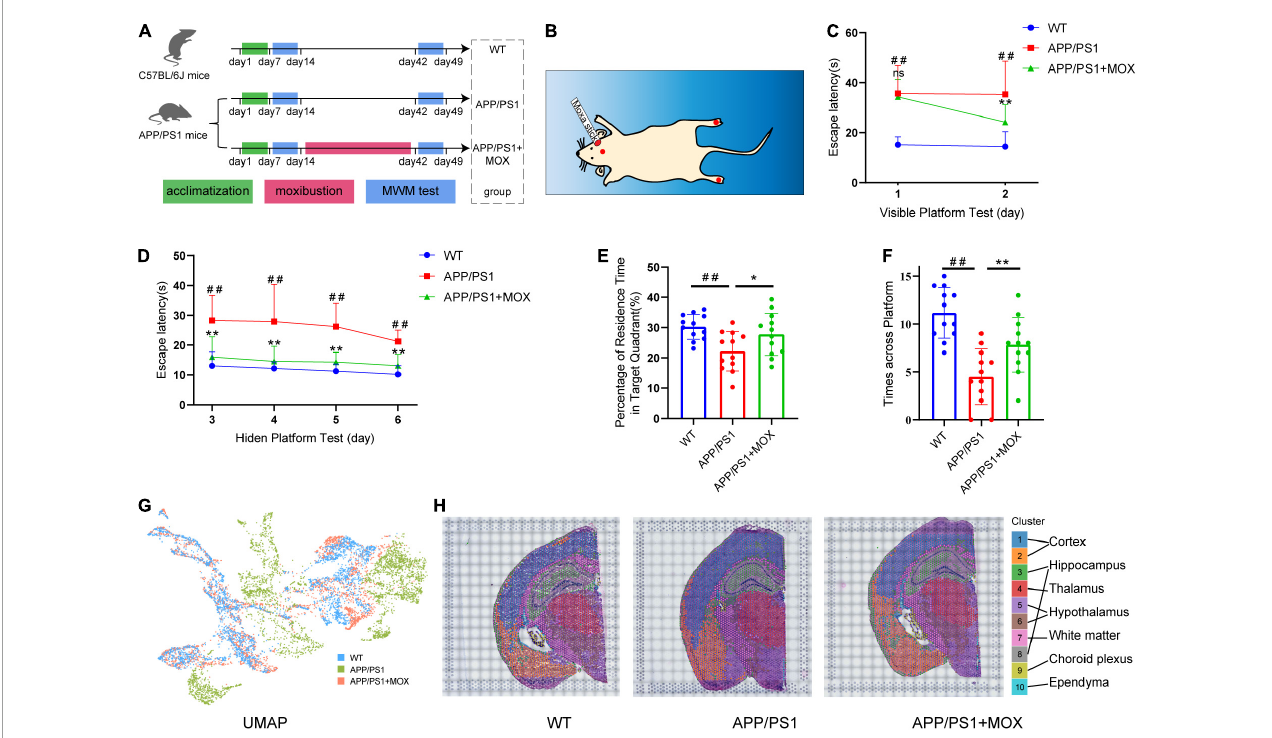
FIGURE1 Moxibustion rescued defects in memory and spatial transcriptomic (ST) characteristic distribution in APP/PS1 mice. (A) Flowchart of the experiment. The Morris water maze (MWM) test was carried out on 5-month-old mice. After 7 days of the MWM test, the mice were treated for 4 weeks continuously, and then the MWM test was conducted again. (B) Schematic of the locations of the acupoints in mice. The red dot on the head of the mouse is the GV20 acupoint, and the foot center is the KI1 acupoint (C,D) . Learning curves of wild-type (WT), APP/PS1, and APP/PS1 + MOX mice in the MWE test with visible (C) and hidden (D) platforms. (E,F) Percentage of residence time in the target quadrant (E) and crossing platform times (F) of mice. (G) UMAP plot shows the differences among groups. There was more overlap between APP/PS1 + MOX (red) and WT (blue), but APP/PS1 (green) is relatively separate. (H) Cluster graph in each sample obtained by Graph-based clustering. Different colors and lines corresponded to different clusters and brain regions. One-way ANOVA test with post-test # P < 0.05, ## P < 0.01, APP/PS1 vs. WT; * P < 0.05, ** P < 0.01, APP/PS1 + MOX vs. APP/PS1; ns. P >